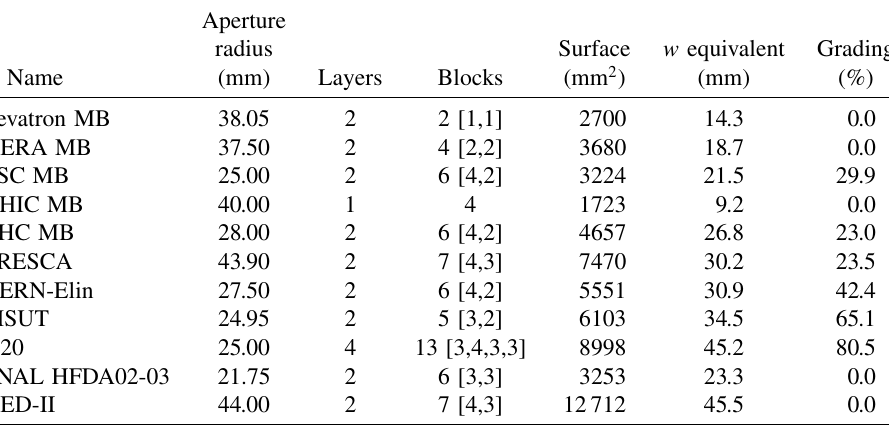
TABLE VI. Parameters of coil layouts of 11 superconducting dipoles.